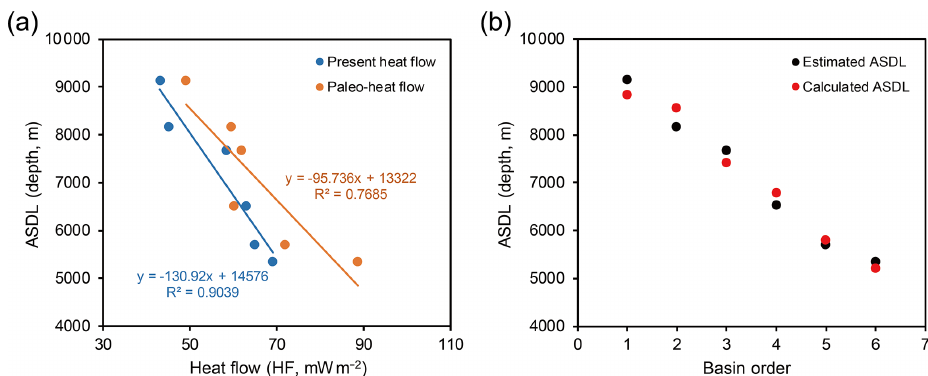
Figure 5. The quantitative relationships among the ASDL, heat flow, and kerogen type for the six basins. (a) Relationship between ASDLs and heat flows. (b) The comparison of the modeled depths through Eq. (1) and estimated depths of the ASDLs. Basin order: 1 – Tarim Basin;